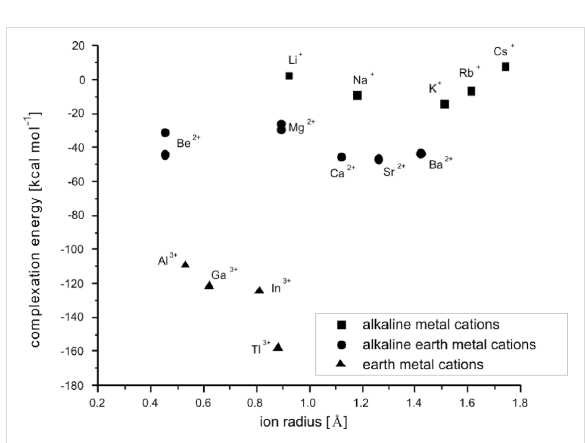
Figure 11: RB3LYP/LANL2DZp complexation energies for [M 2.bpy.bpy] m+ according to Scheme 1, plotted against the ionic radius of M m+ ; for the data see Table